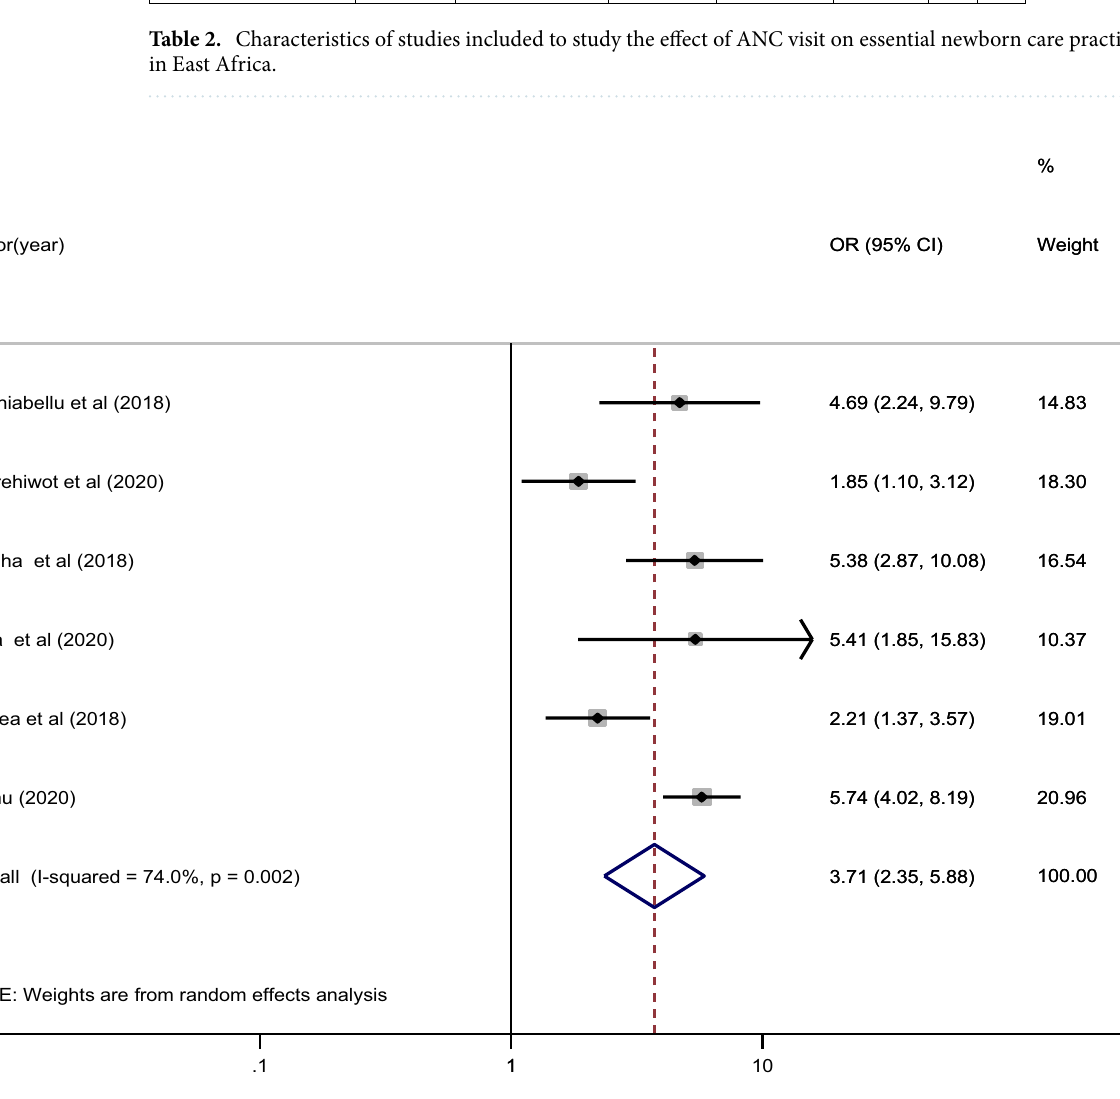
Figure 4. The pooled effect of ANC visit on Essential newborn practice among women in East